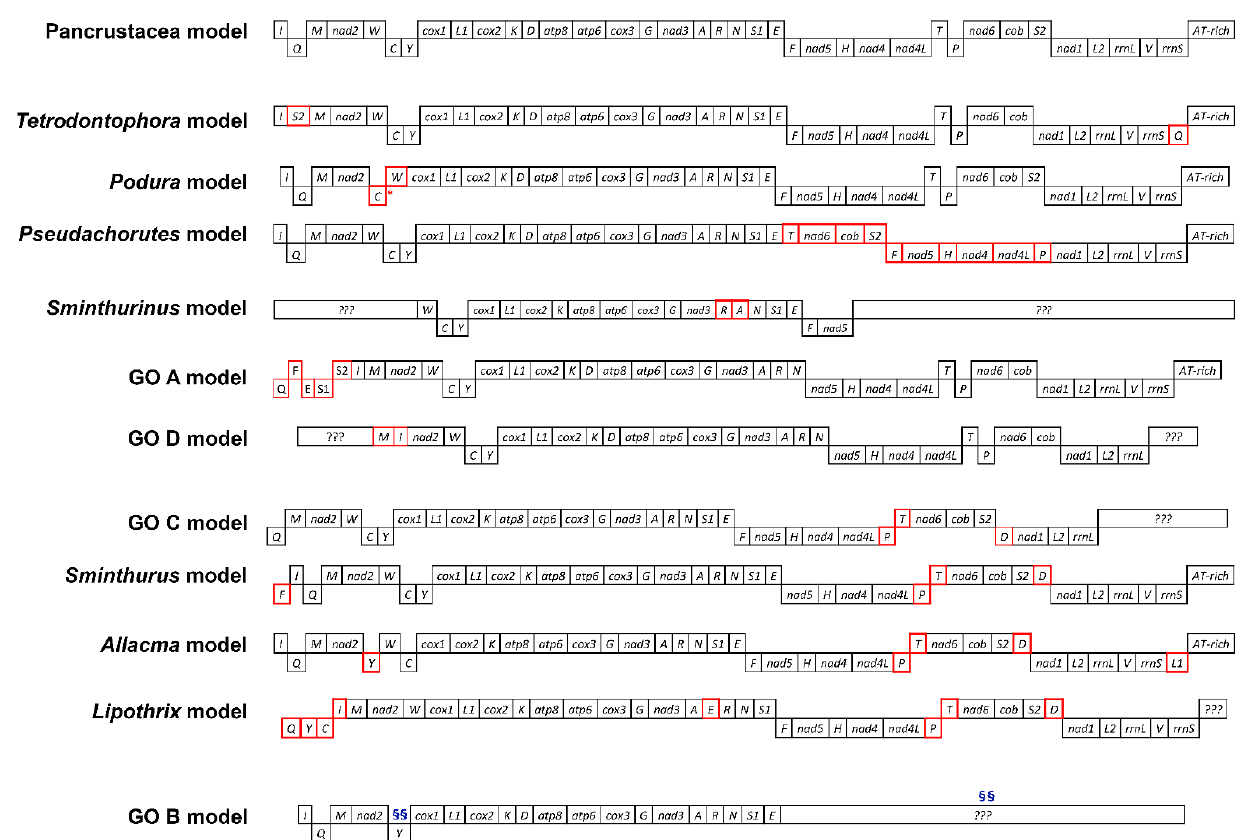
Figure 2. Collembola gene orders available up to June 2020. The Pancrustacean model is considered to be ancestral within the springtail lineage. All derived gene arrangements, with respect to the basal model, show translocations as red boxes, deletions as red asterisks (*), and possible translocations as blue section signs (§). Incomplete sequences are identified with question marks.